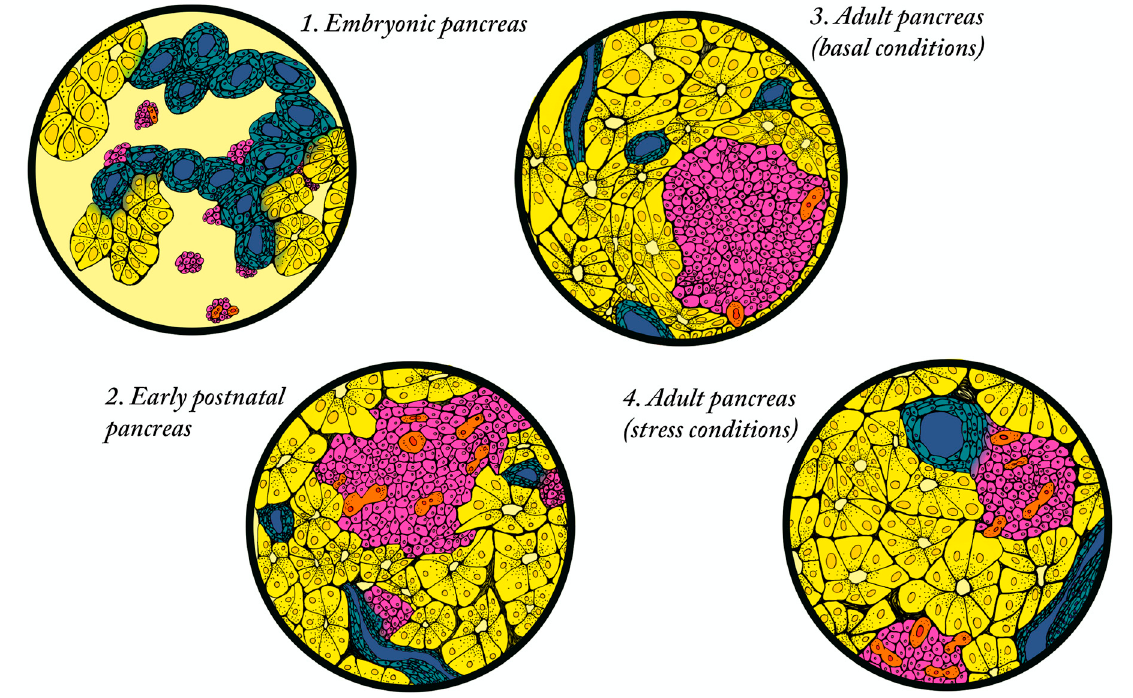
Figure 1. Different mechanisms of endogenous beta cell regeneration exist throughout life. ( 1 ) Embryonic pancreas. During embryonic development, the beta cells primarily arise from the Neurogenin3 (NEUROG3)-expressing endocrine progenitor population located in epithelial ducts through a mechanism of neogenesis. ( 2 ) Early postnatal pancreas. In the first two weeks after birth, the beta cell population expands through a combination of neogenesis and replication of existing beta cells. ( 3 ) Adult pancreas in basal conditions. In the adult, a limited number of new beta cells form through replication. ( 4 ) Adult islet in stressed conditions. Adult beta cells exposed to physiological stresses (pregnancy, obesity, insulin resistance, damage) regenerate through both neogenesis (rare) and the replication of existing beta cells. Key: beta cells (pink); epithelial ducts (blue); replicating beta cells (orange); acinar cells (yellow).